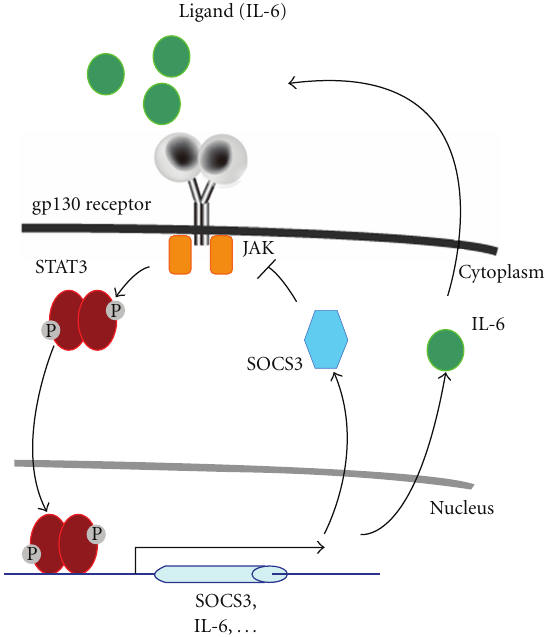
Figure 1: Model of the gp130-STAT3-SOCS3 pathway. IL-6 family ligands activate the gp130 receptor, which subsequently phospho- rylates and activates STAT3 through JAK. Activated and dimerized STAT3 translocates into the nucleus to promote the transcription of various molecules, including SOCS3 and IL-6. SOCS3 inhibits JAK and STAT3 activation. IL-6 is secreted and further activates